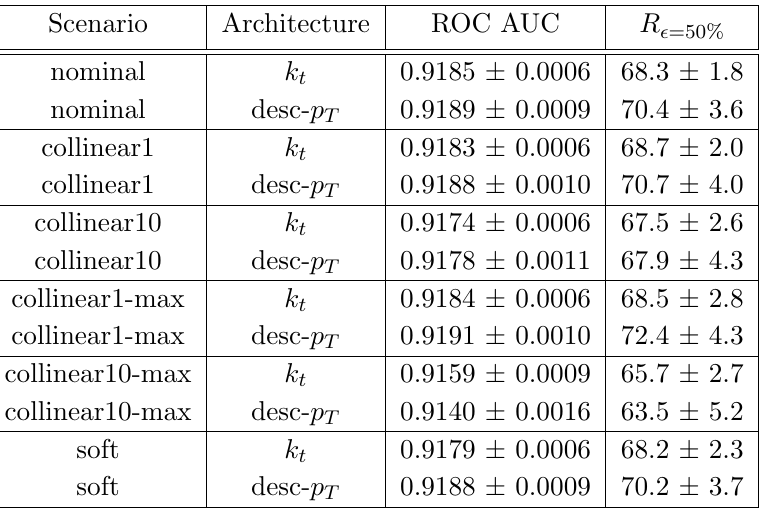
Table 2 . Performance of pre-trained RNN classi(cid:12)ers (without gating) applied to nominal and modi(cid:12)ed particle inputs. The collinear1 ( collinear10 ) scenarios correspond to applying collinear splits to one (ten) random particles within the jet. The collinear1-max ( collinear10-max ) scenarios correspond to applying collinear splits to the highest p T (ten highest p T ) particles in the jet. The soft scenario corresponds to adding 200 particles with p T = 10 (cid:0) 5 GeV uniformly in 0 < (cid:30) < 2 (cid:25) and (cid:0) 5 < (cid:17) <